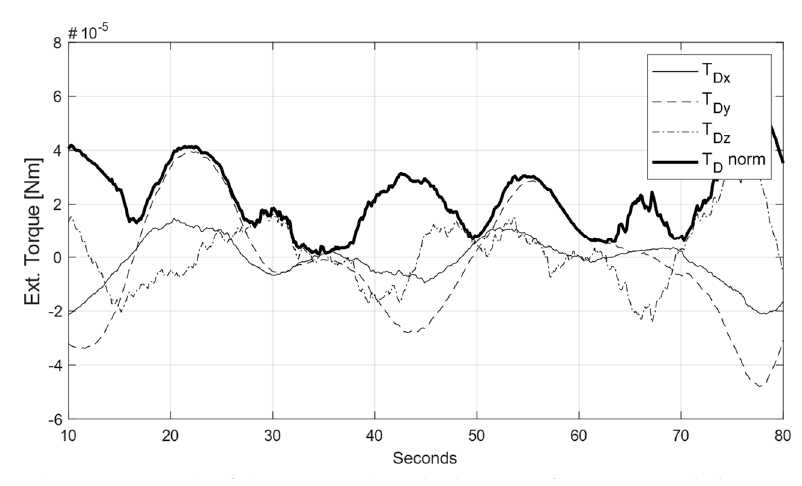
Figure 8. Example of the estimated residual torque after automatic balancing. Table 3. Residual offset vector after balancing.